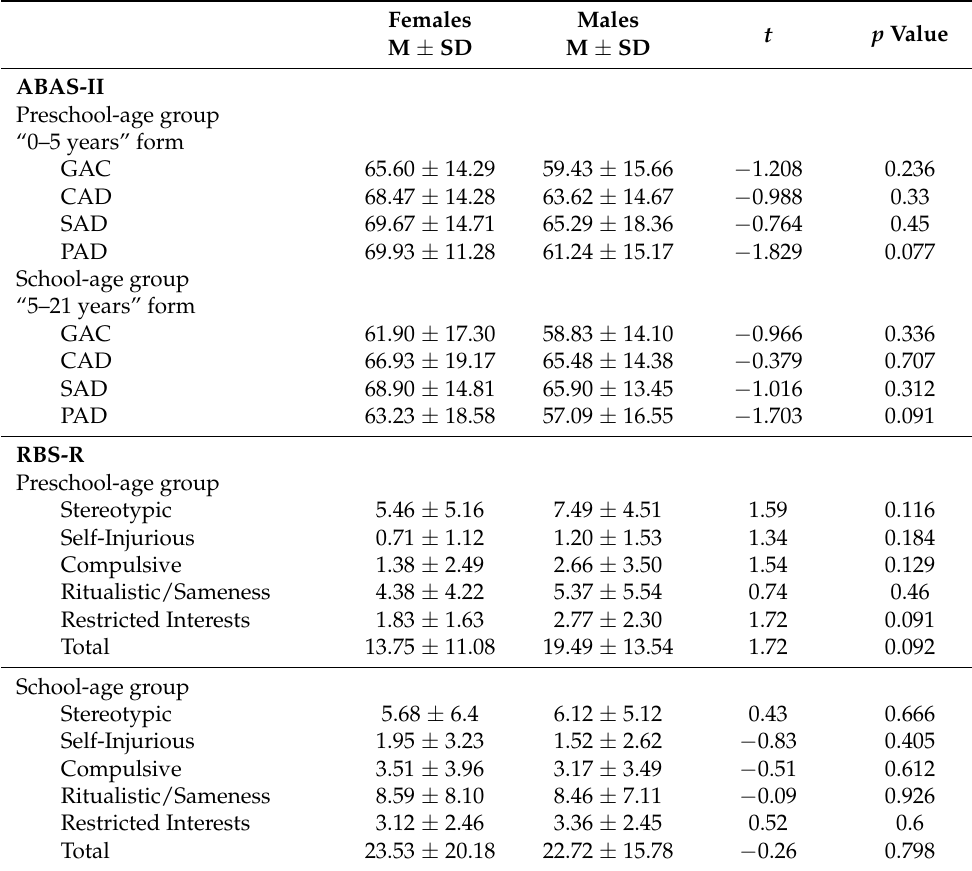
Table 2. Sex Differences in Adaptive Functioning and RRBs.